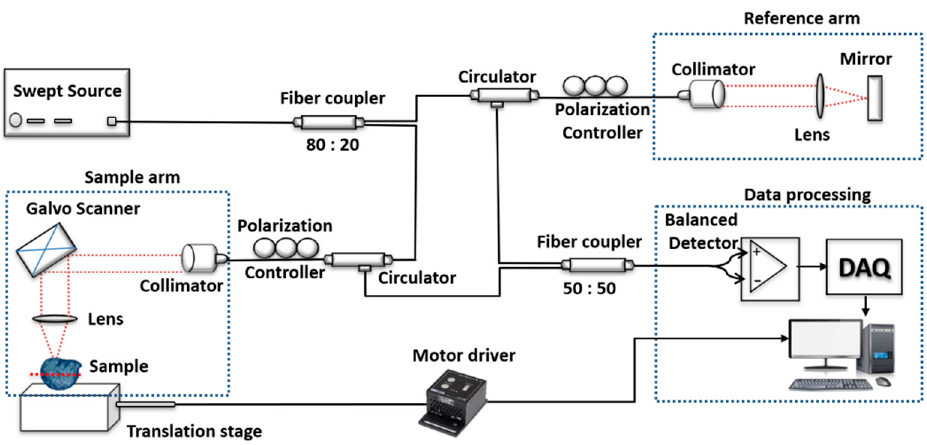
Figure 1. Schematic diagram of the swept-source optical coherence tomography (OCT) system configuration. DAQ: Data acquisition.